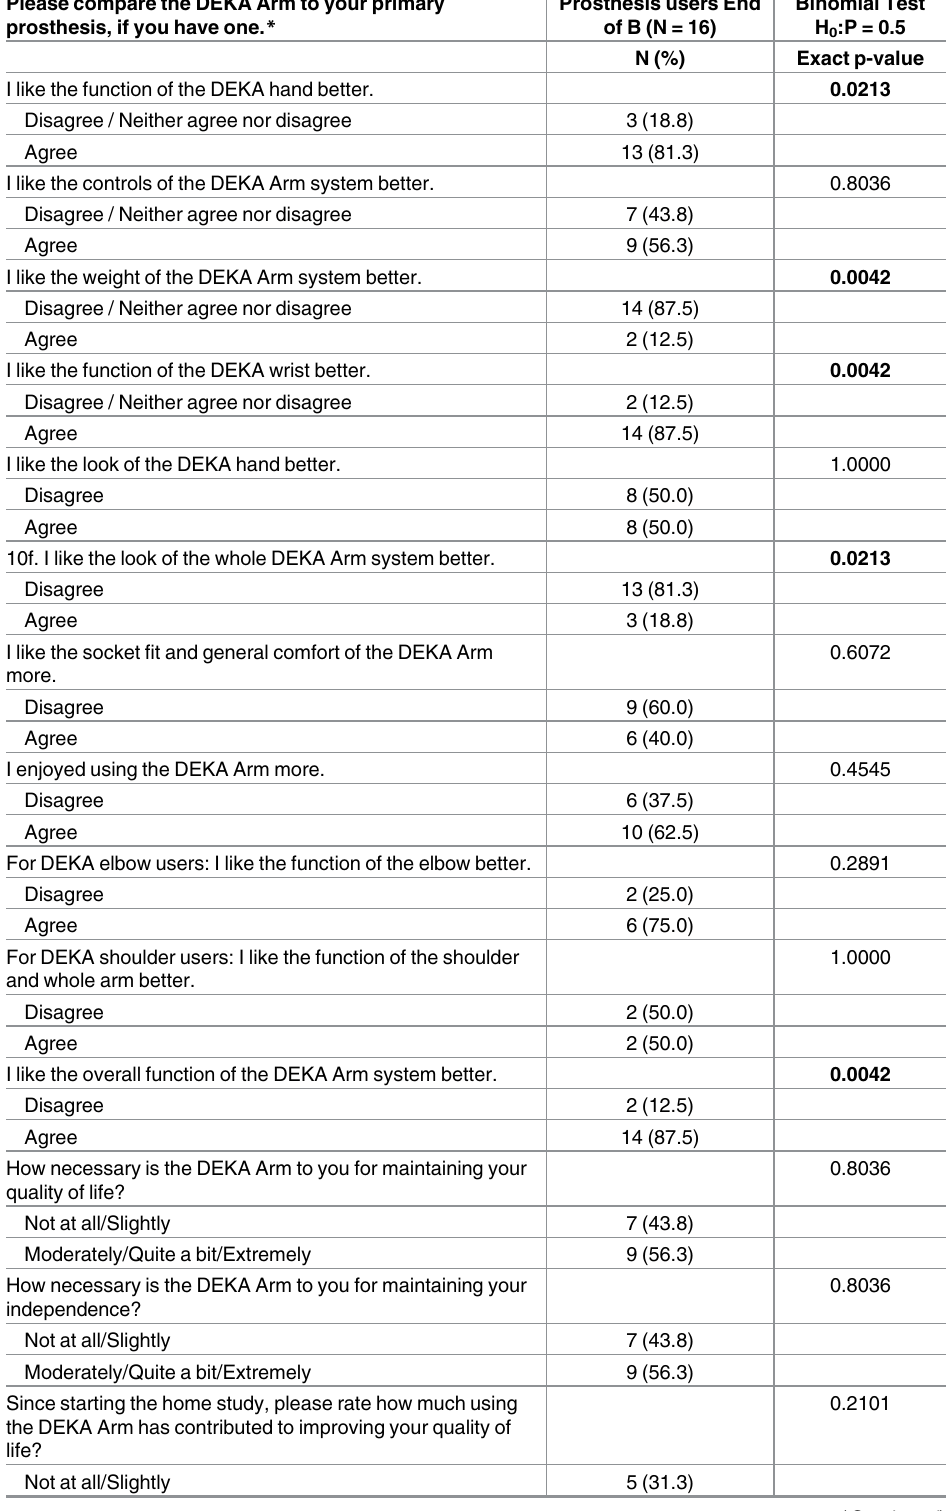
Table 4. Survey items completed by prosthesis users only, administered at the end of Part B. Please compare the DEKA Arm to your primary prosthesis, if you have one. *